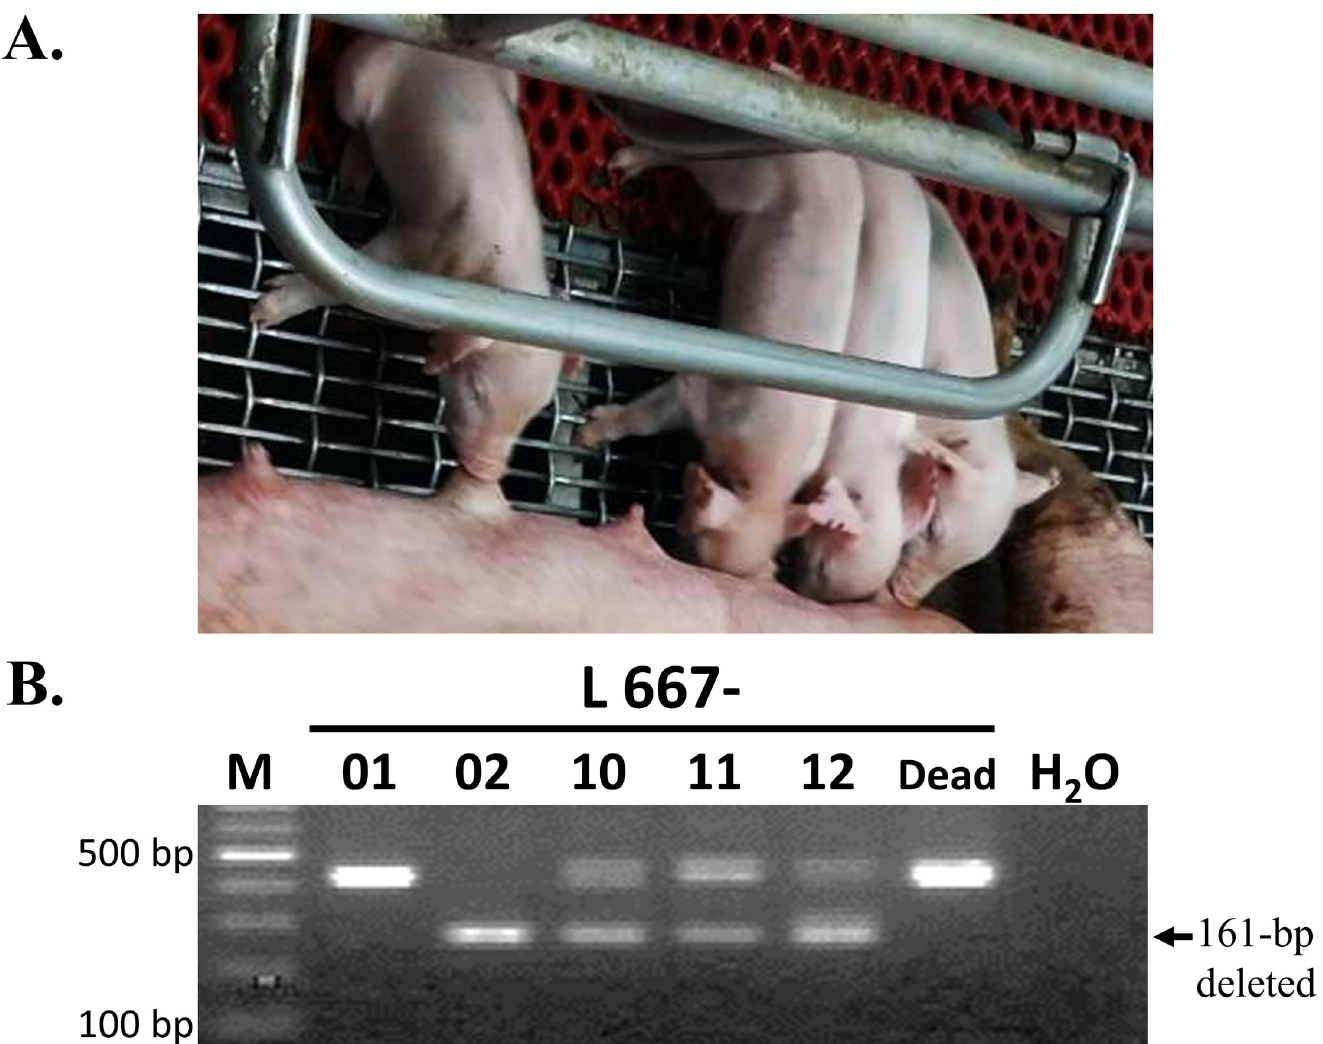
Fig 3. Generation of CMAH gene-edited pigs. A. Four lines of CMAH gene-edited piglets (1 male, L667-02, and 3 females, L667-10, 11, and 12) were obtained. B. CMAH KO piglets were analysed and screened by PCR. The amplicons were produced a 161-pb deleted band when two sites editing occurred simultaneously.